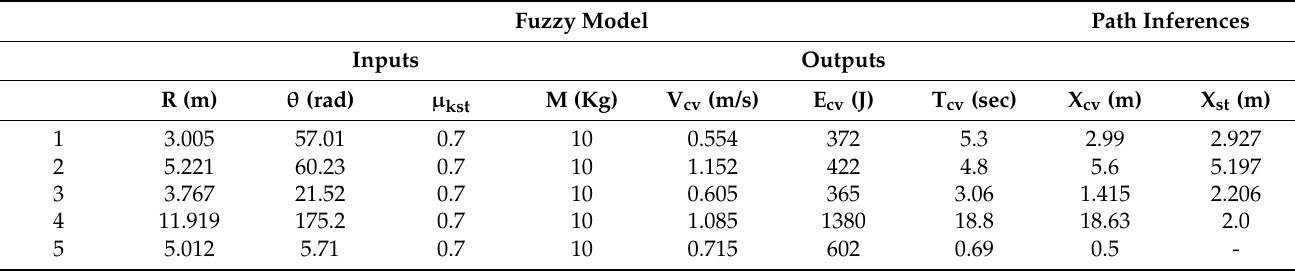
Fuzzy Model Path